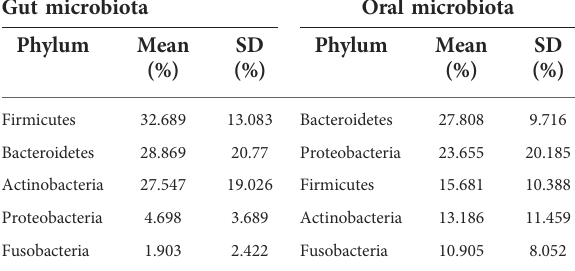
TABLE 1 Top fi ve abundant phyla in oral and gut